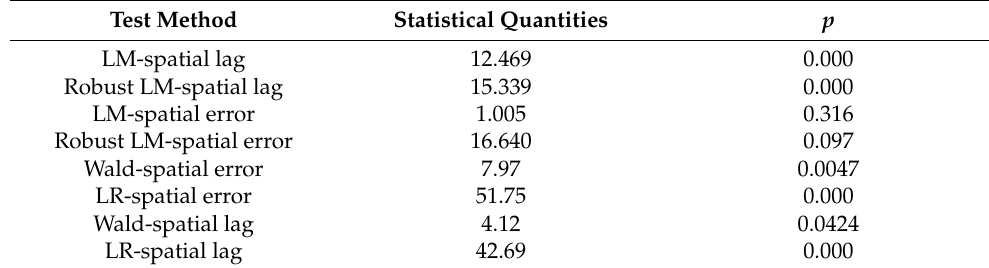
Table 3. Test results of the spatial panel econometric